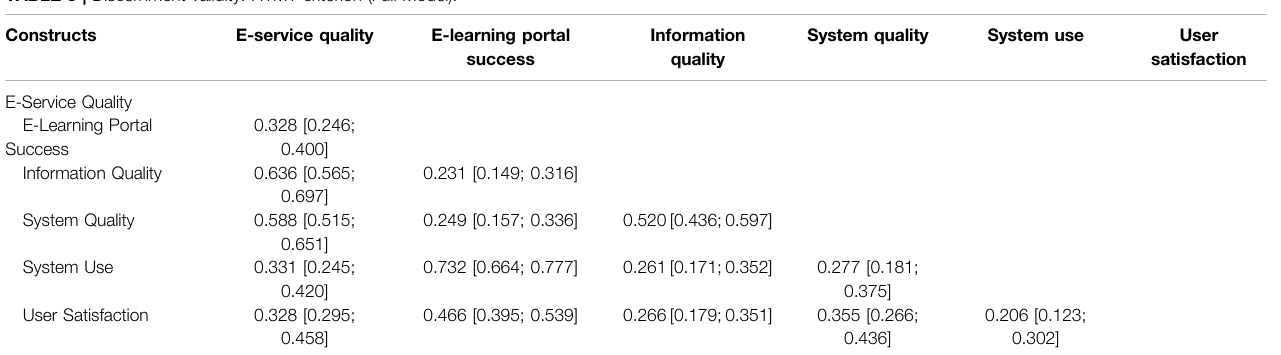
TABLE 5 | Discernment validity: HTMT criterion (Full Model).